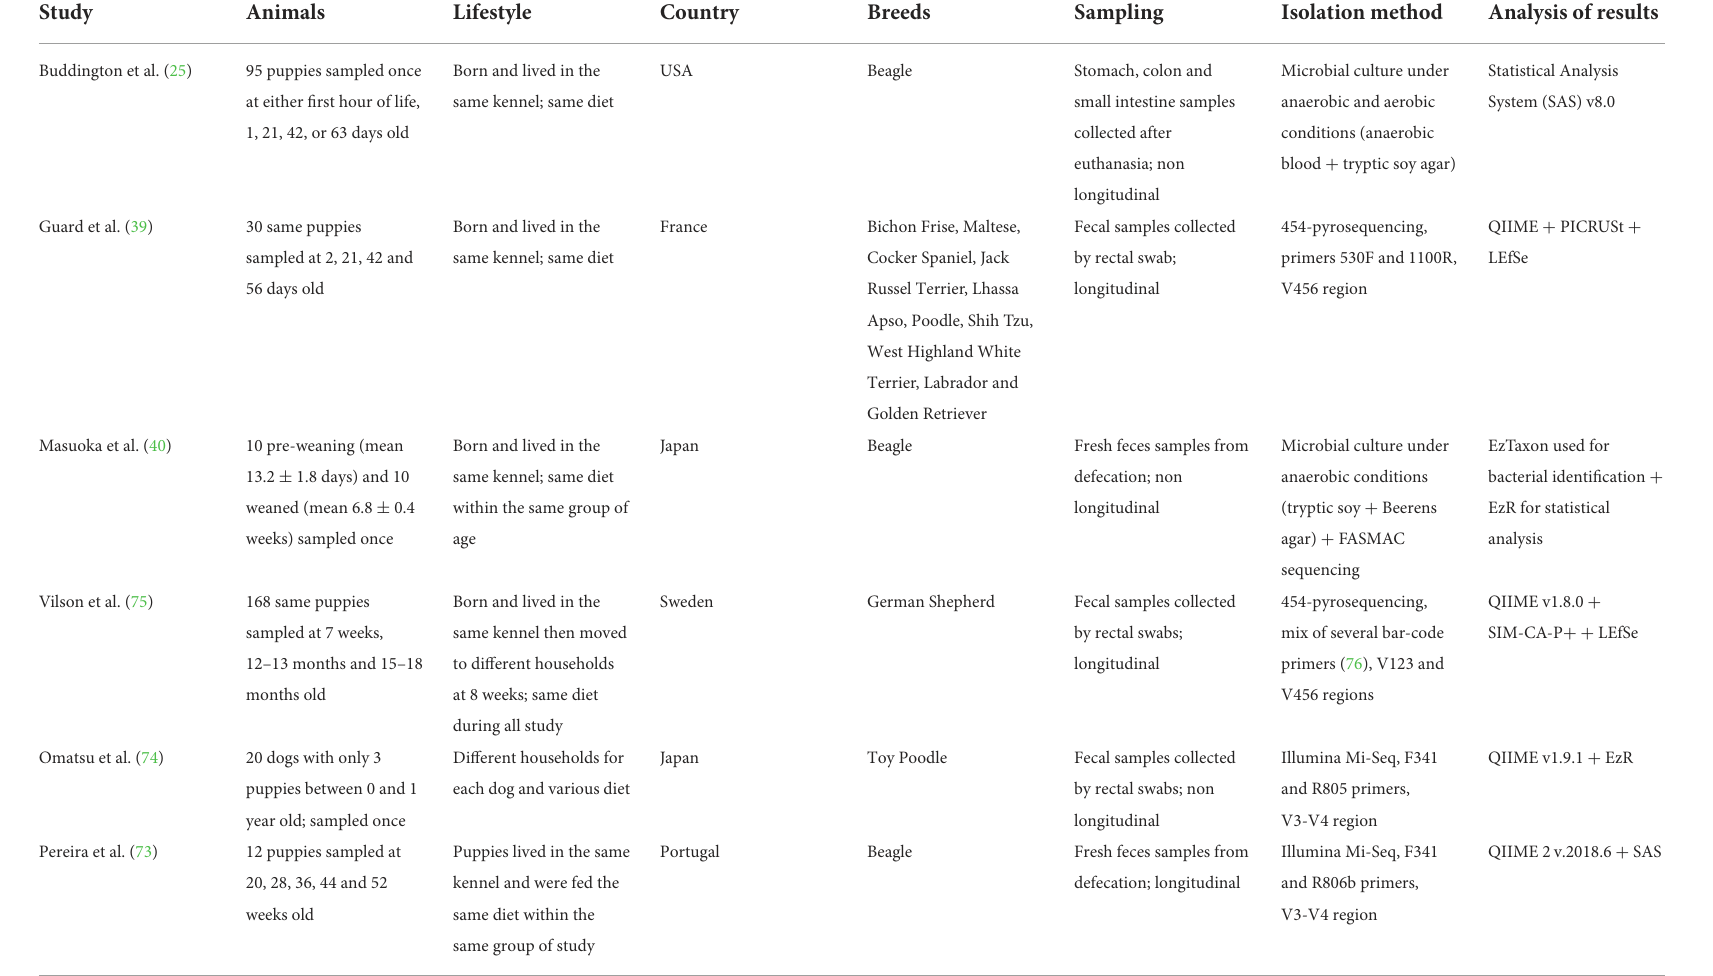
TABLE 2 Methodologies and material used in the different studies on growing dog